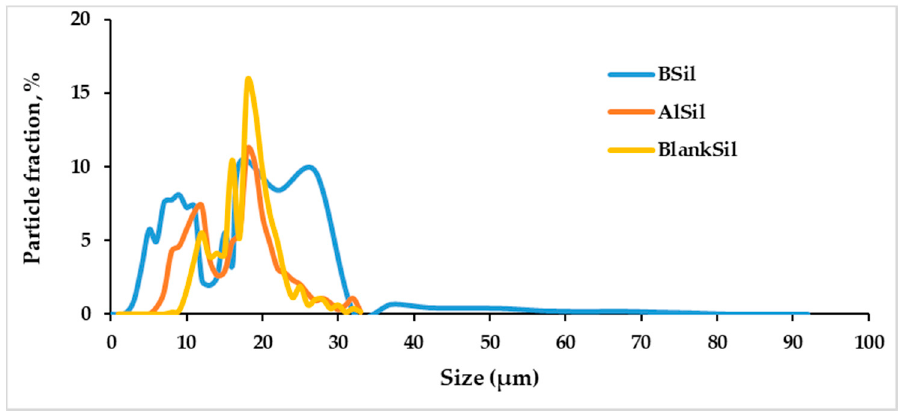
Figure 2. Distribution of the particle size of sol − gel matrix powders of BlankSil, BSil and AlSil.